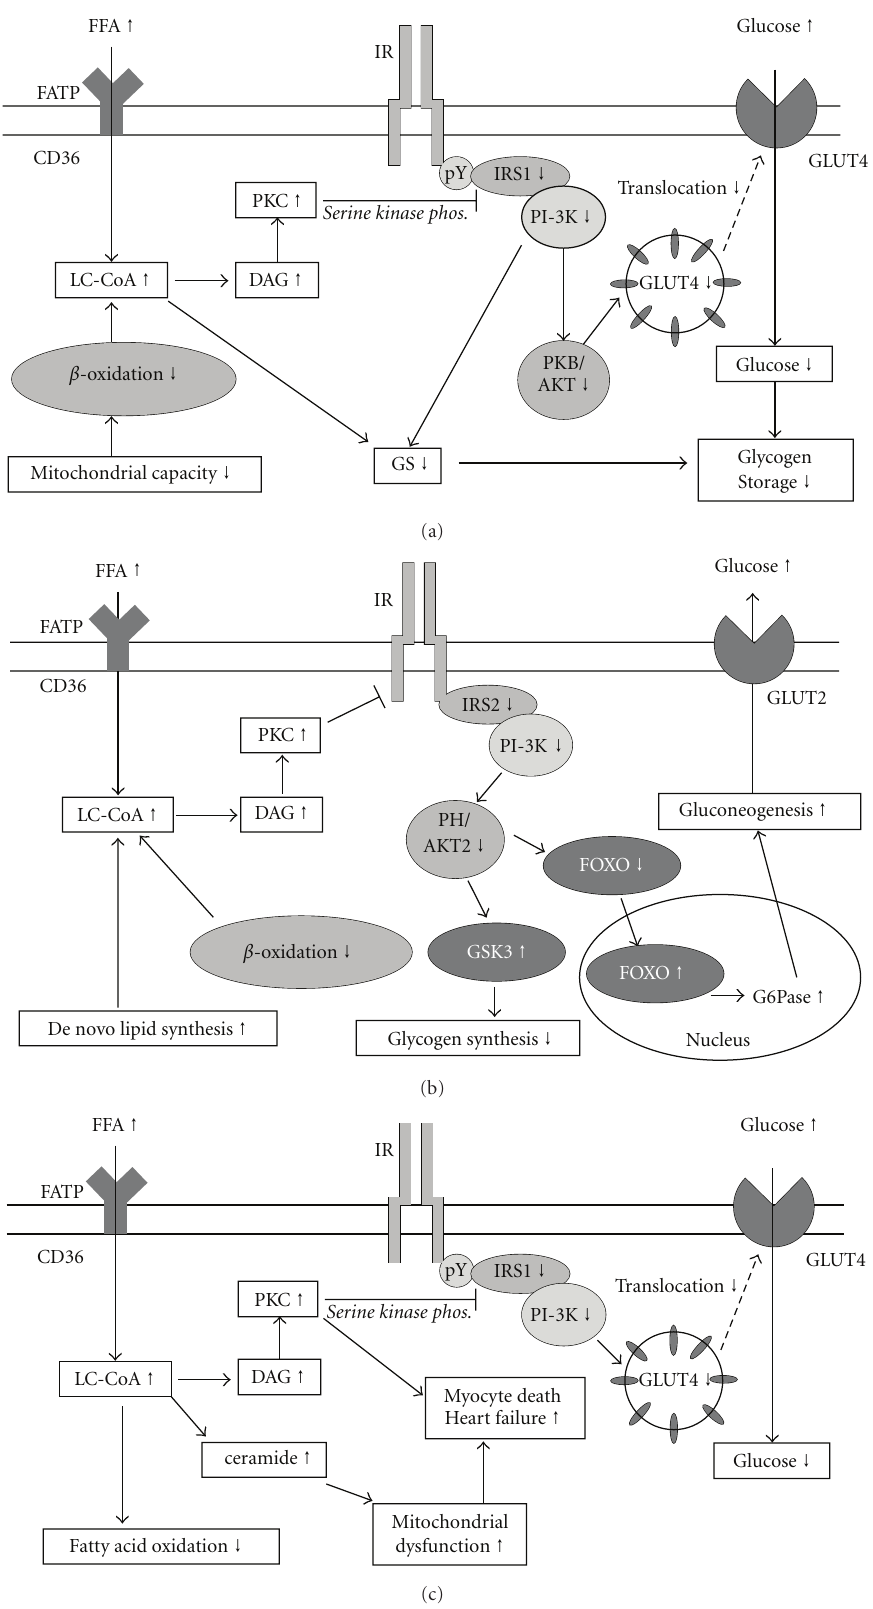
Figure 2: (a) cellular processes leading to insulin resistance in the skeletal muscle cell; (b) cellular processes leading to insulin resistance in the liver cell; (c) cellular processes in the cardiomyocyte leading to myocardial